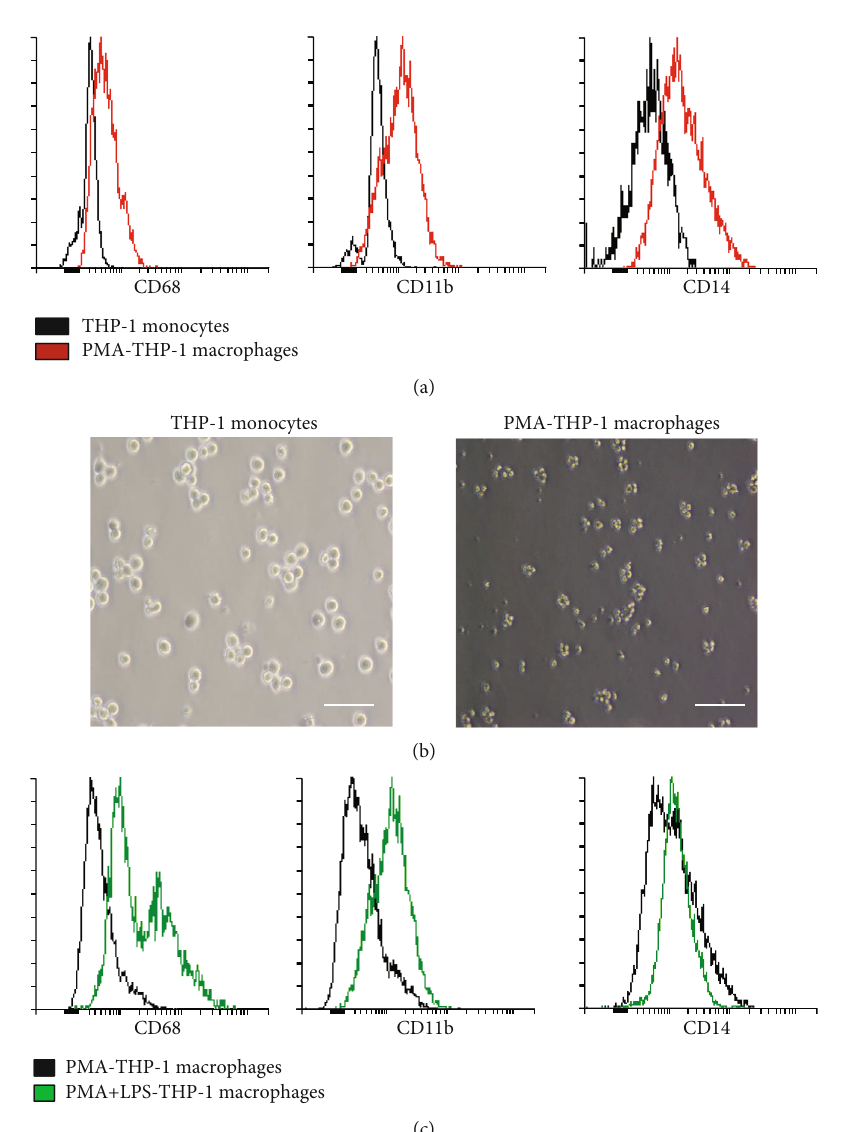
Figure 1: Characterization of THP-1 cells. (a) Flow cytometric histograms of THP-1 monocytes and PMA-THP-1 treated cells for 24 hrs. (b) The morphological appearance of THP-1 cell line cultured in RPMI media: THP-1 monocytes and macrophages; PMA treated THP-1. (c) Flow cytometric histograms of PMA-THP-1 macrophages and PMA+LPS-THP1 macrophages activated by LPS for 24